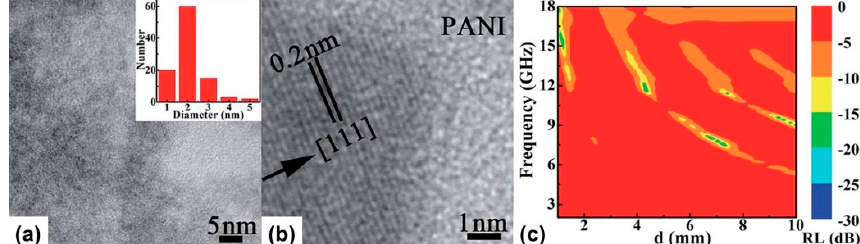
Figure 8. TEM image of ( a ) Ni@PANI nanocomposite and ( b ) HRTEM image of one Ni nanoparticle. The inset in ( a ) shows the size distribution of the Ni nanoparticles. ( c ) Color map of calculated reflection loss values with the thickness of 1.0–10.0 mm as a function of frequency. Reprinted with permission from Reference [118].